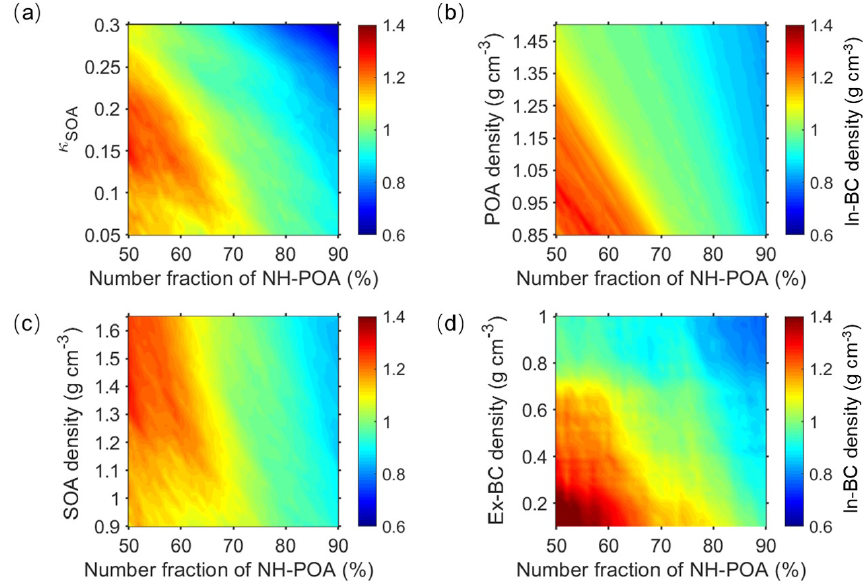
Figure 1. Sensitivities of In-BC density to the variations in the number fraction of the nearly hydrophobic (NH) POA and hygroscopic parameter of OA ( k SOA ) (a) , POA density (b) , SOA density (c) , and the externally mixed BC density (d) .